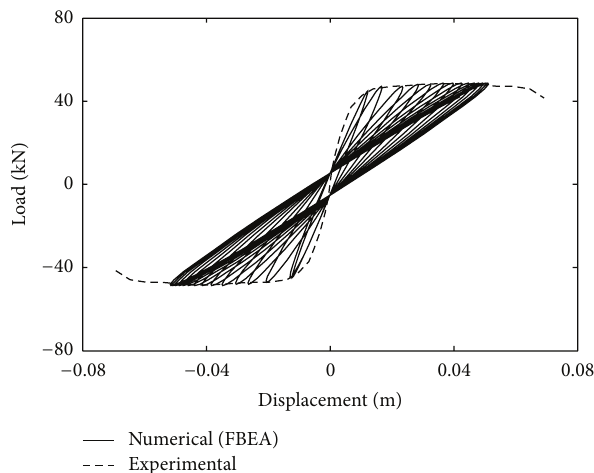
Figure 5: Comparison of experimental and numerical responses of RC